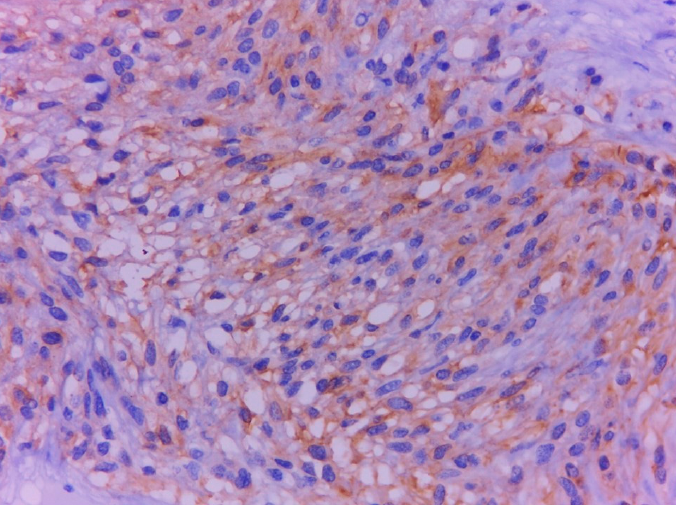
Figure 12. GIST tumor cells show membrane positivity for DOG1 in immunohistochemical staining, ×400.